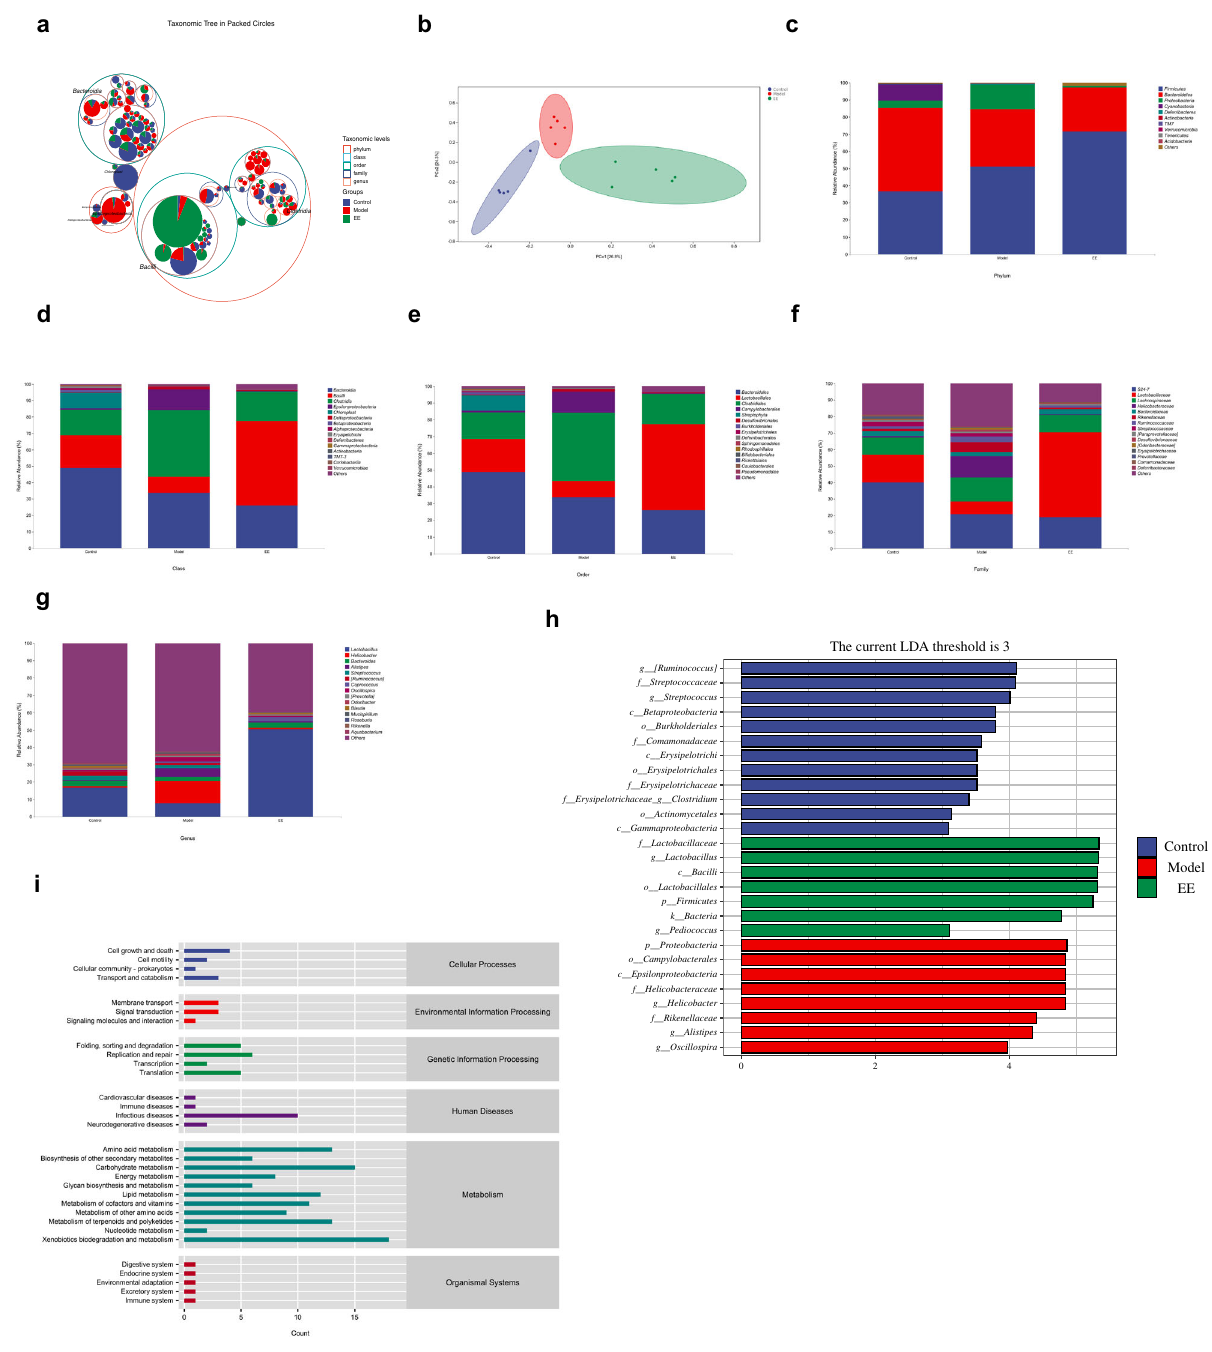
Fig. 3 EE intake reshapes the gut microbiota in irradiated mice. a Taxonomic tree in packed circles. b Principal coordinates analysis plot of Bray – Curtis. c The relative abundance of bacteria at phylum level; d the relative abundance of bacteria at class level; e the relative abundance of bacteria at order level; f the relative abundance of bacteria at family level. g The relative abundance of bacteria at genus level. h Linear discriminant analysis (LDA) effect size showing the most differentially signi fi cant abundant taxa enriched in microbiota among the EE group, model group, and control group. (LDA > 3). i Microbial functions were predicted by PICRUSt2 upon KEGG ( n =